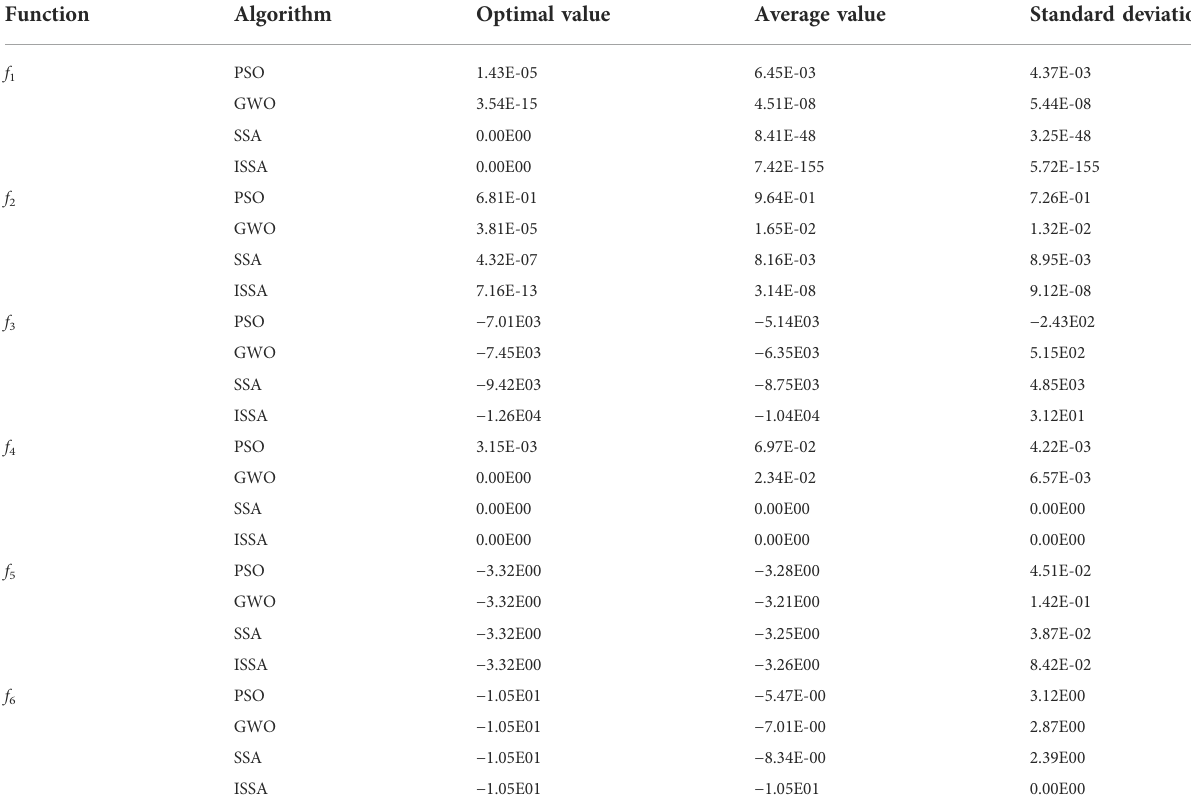
TABLE 3 Function test